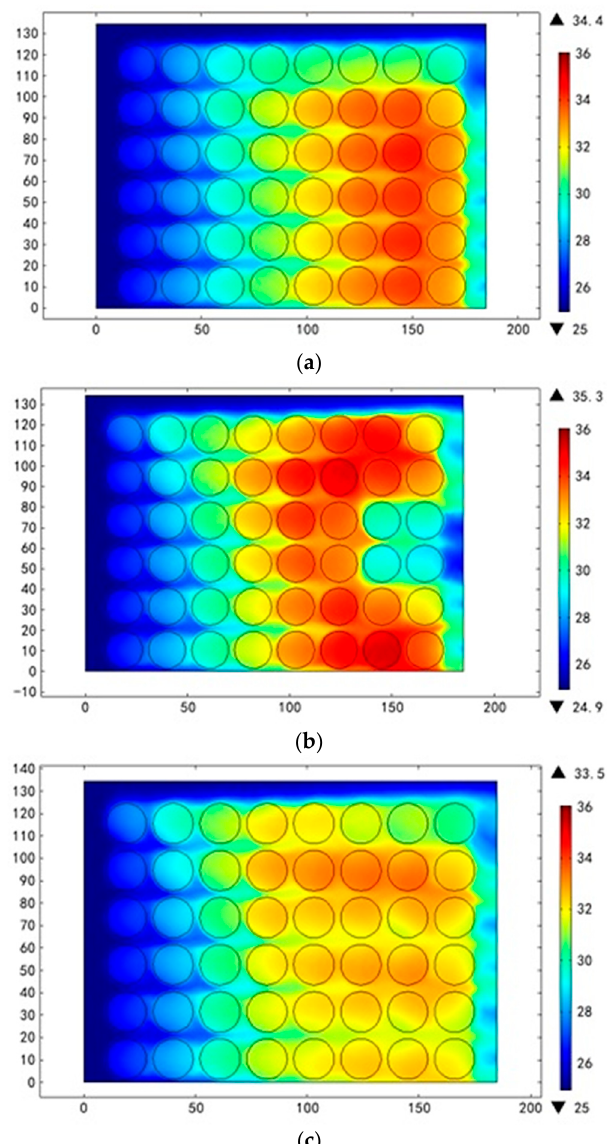
Figure 8. Battery temperature profiles with different inlet modes at the rate of 1.0 m/s, 25 °C and 1C discharging rate. ( a ) One inlet; ( b ) two inlets; and ( c ) seven inlets.